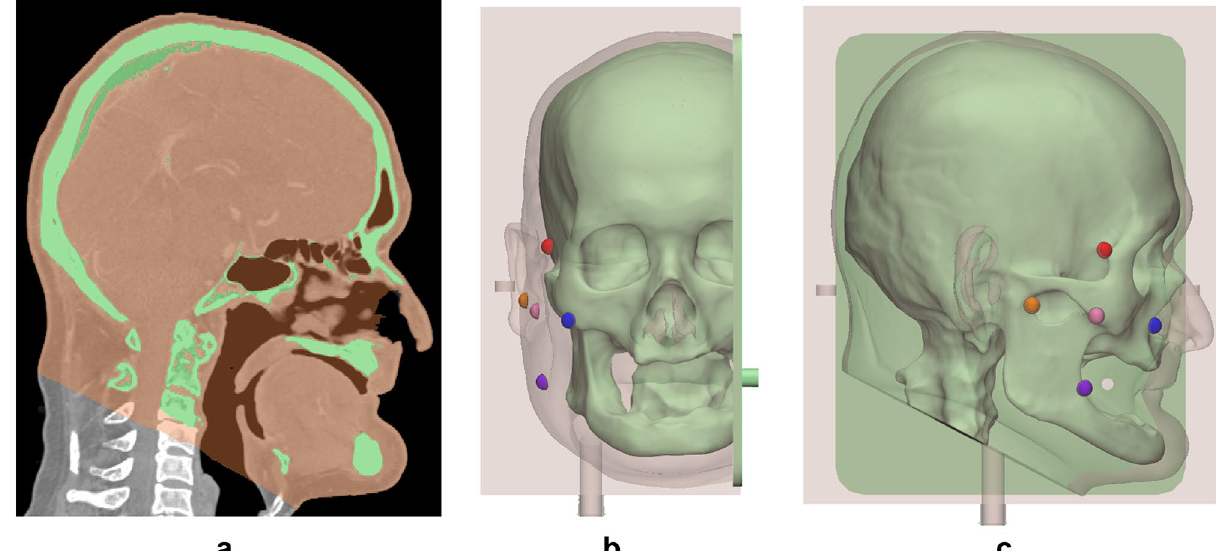
Figure 6. Visualization of segmented anatomies including the skin and skull, and the modeled in-vitro phantom in CT images of a 59-year-old patient with malignant melanoma. ( a ) Sagittal view of segmented anatomies. ( b ) Front view of modeled in-vitro phantom. ( c ) Sagittal view of modeled in-vitro phantom. (skin, peach; skull, light green; cancer top, red; cancer center, pink; cancer bottom, purple; cancer left, orange; cancer right;